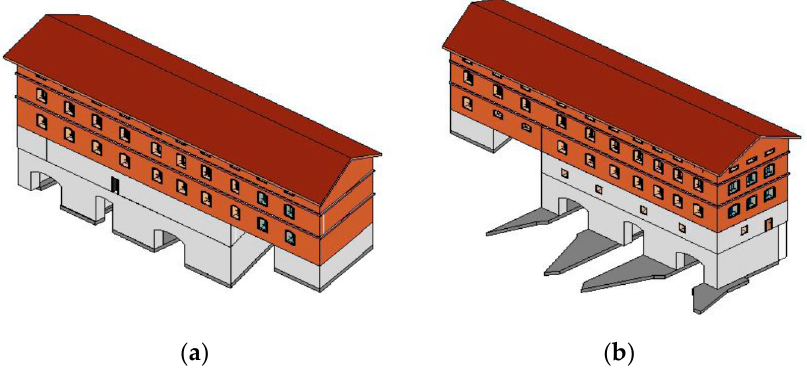
Figure 5. BIM model of the body of the factory: first phase, original condition. ( a ): Front view; ( b ) Rear view.